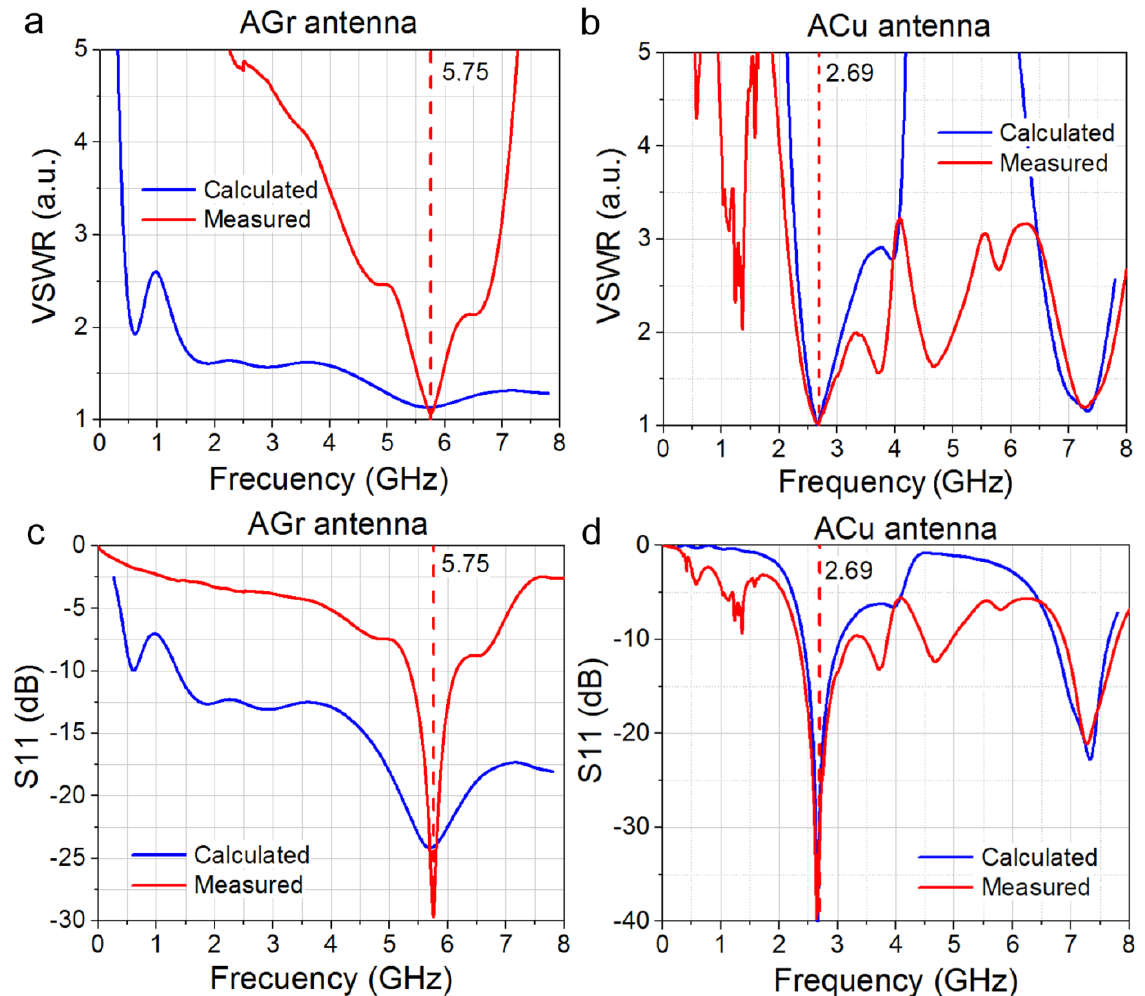
Figure 5. Frequency dependence of the ( a , b ) the voltage standing wave ratios VSWR; ( c , d ) the calculated and measured reflection coefficients S11 of AGr and ACu antennas.